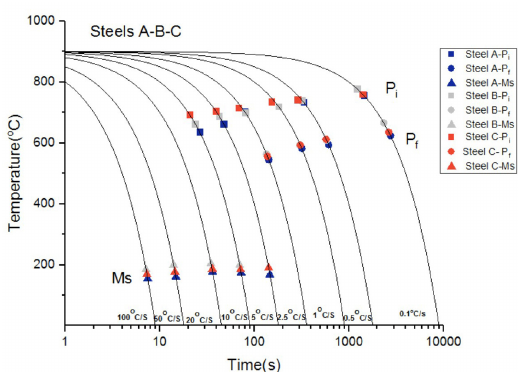
Figure 4. Experimentally determined CCT diagrams of steels A, B and C. Austenitizing temperature: